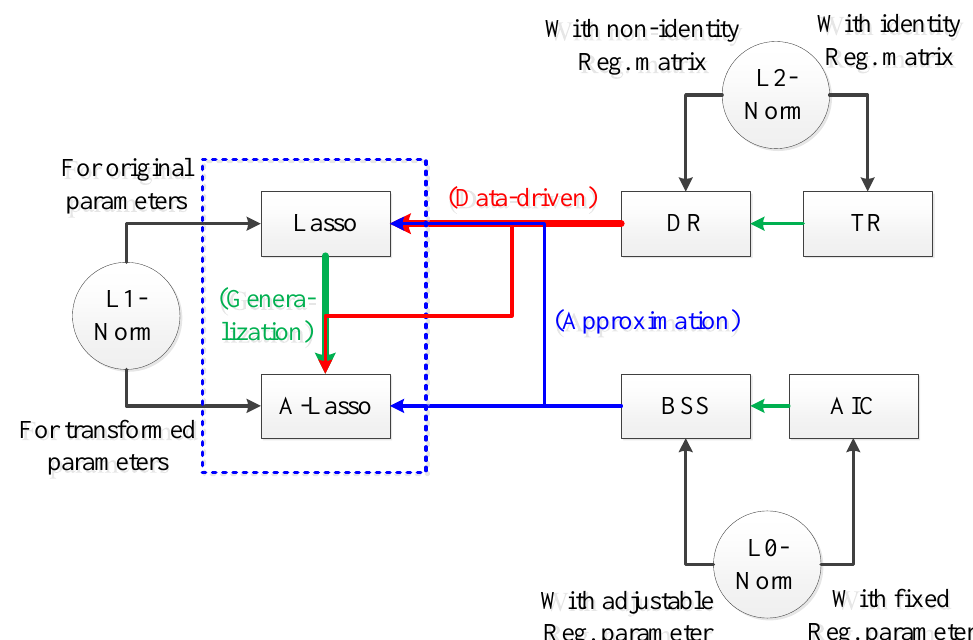
Figure 1. Relations between different regularization schemes. Reg. = regularization; BSS = best subset selection [39]; AIC = Akaike information criterion [40]; Lasso = least absolute shrinkage and selection operator [20]; A-Lasso = adaptive Lasso [27]; TR = Tikhonov regularization [41]; DR = DDK regularization [4,5]. “A → (Data-driven)B” = B can be viewed as a data- driven version of A; “A → (Approximation)B” = B can be viewed as an approximated version of A; “A → (Generalization)B” = B can be viewed as a generalized version of A. The schemes in the dotted blue box are the focus of the current